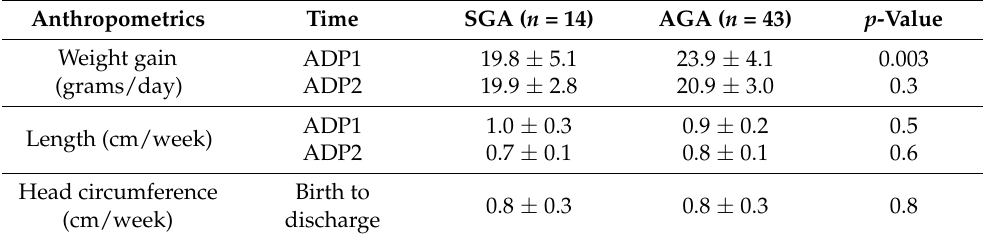
Table 2. SGA and AGA anthropometrics from birth to ADP evaluations ( n =